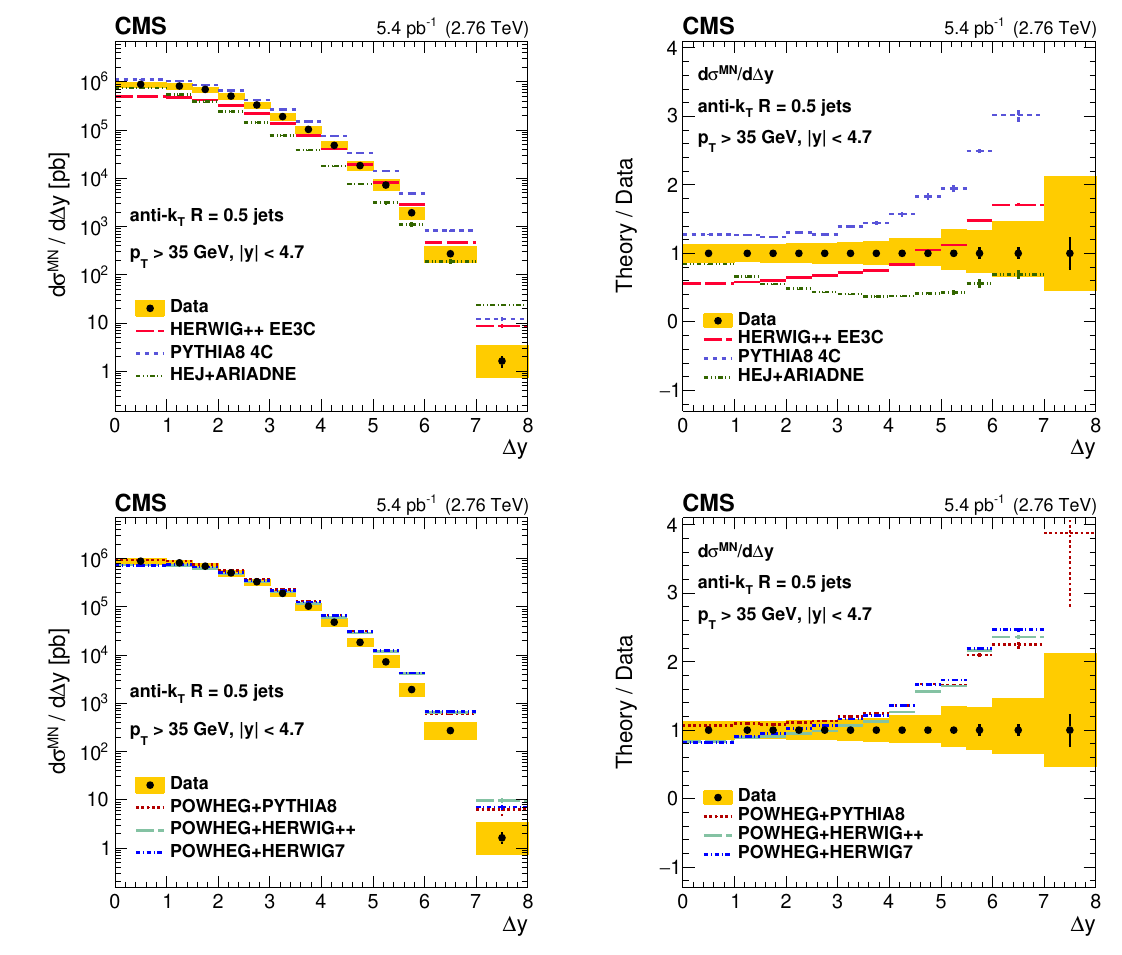
Figure 3 . Differential cross section d σ MN / d∆ y for MN dijet production. The upper and lower rows present the comparison with different MC models. The plots on the left present the cross sections and those on the right the ratio of theory to data. The systematic uncertainties are indicated by the shaded bands and the statistical uncertainties by the vertical